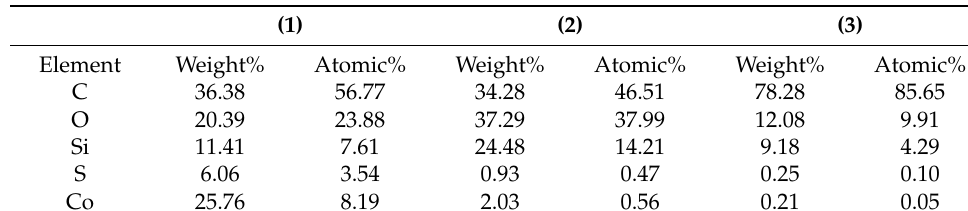
Table 1. EDX for the nanocomposites (1), (2) and (3).